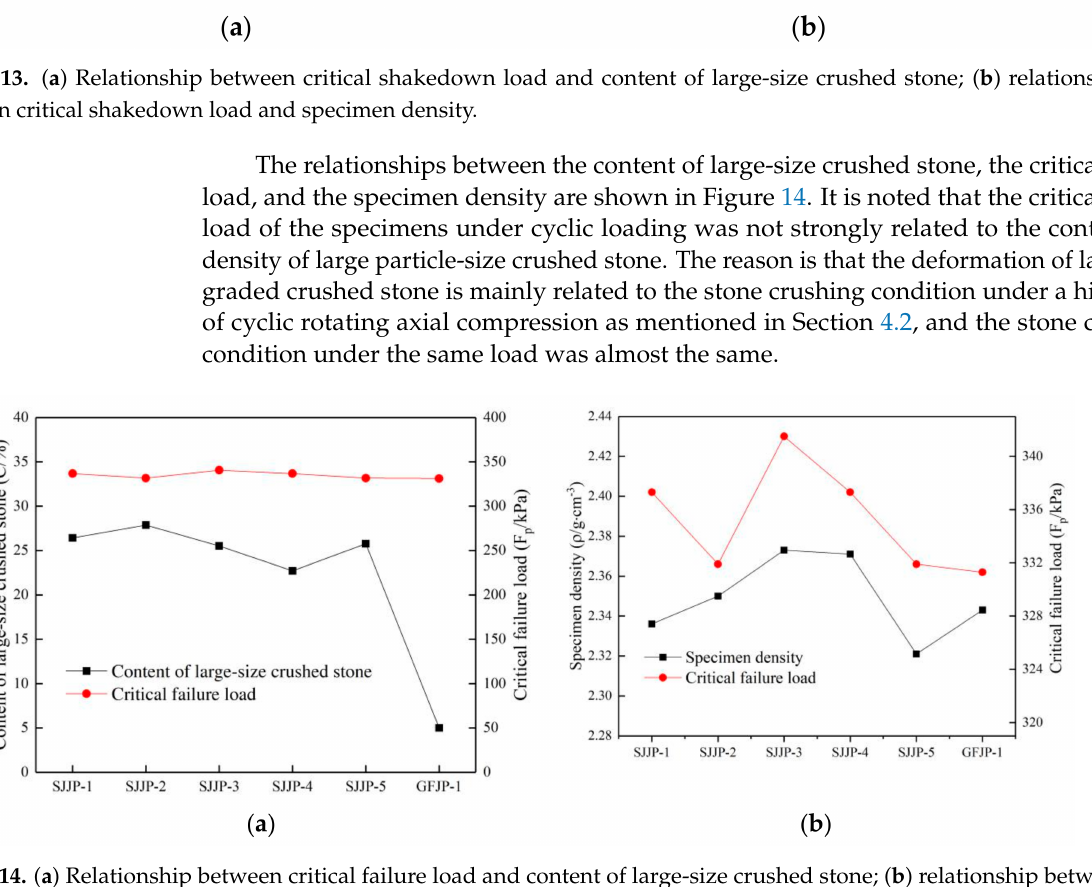
Figure 14. ( a ) Relationship between critical failure load and content of large-size crushed stone; ( b ) relationship between critical failure load and specimen